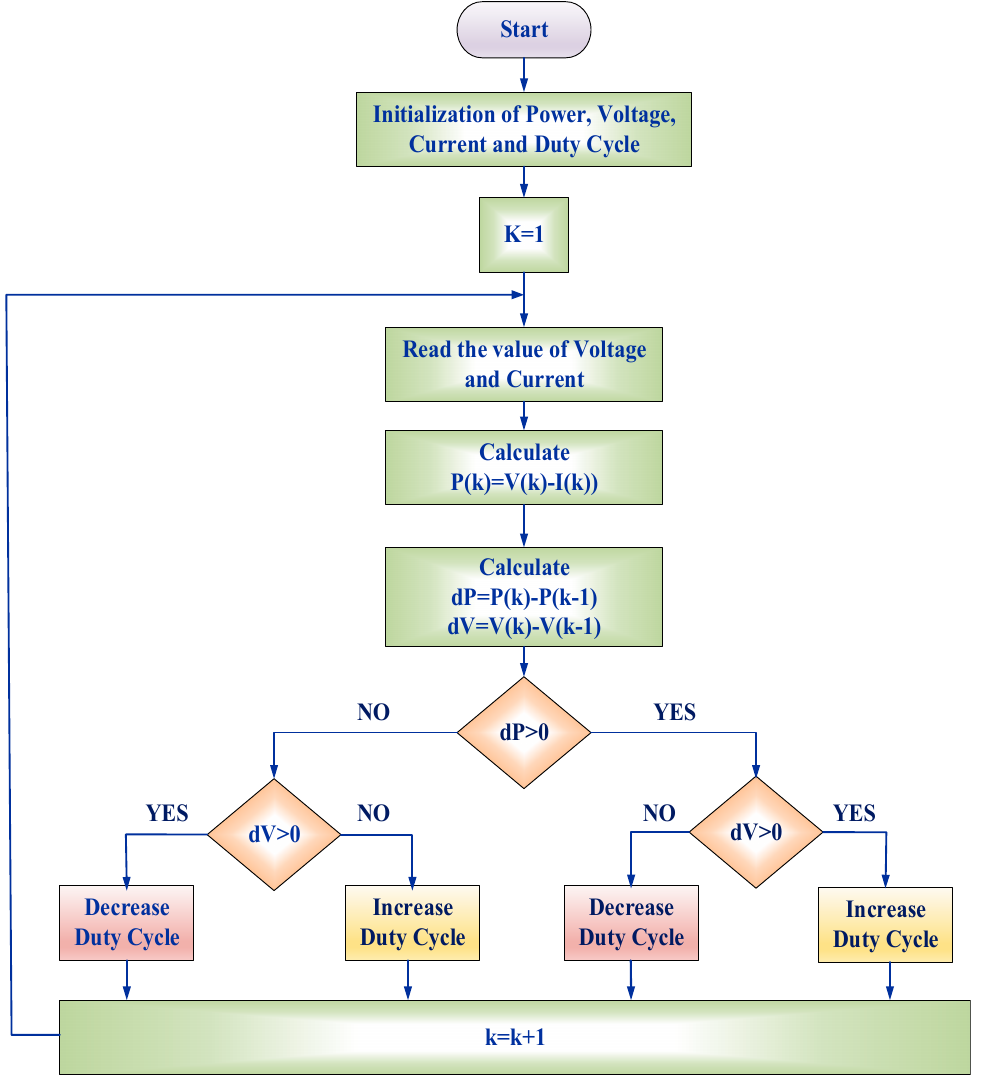
Figure 5. Flowchart of Perturb and Observe method.